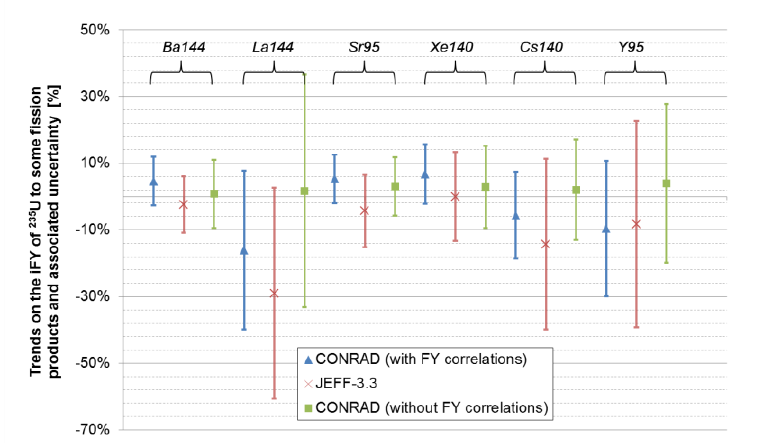
Fig. 2. Feedbacks on JEFF-3.1.1 correlated iFY data after assimilation of one MERCI-1 experimental value (42 days) with CONRAD